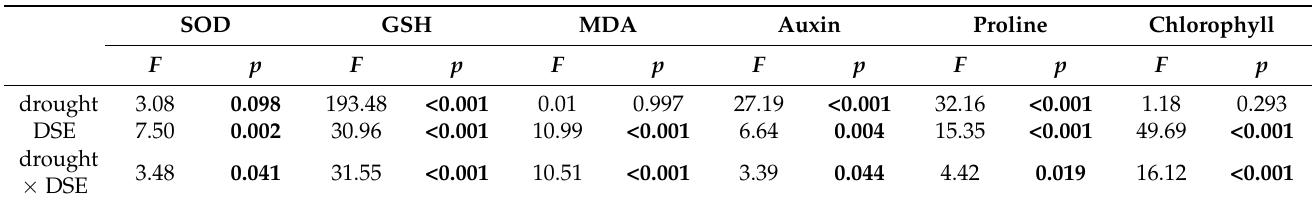
Table 2. Analysis of variance for the effects of drought stress and dark septate endophyte (DSE) inoculation on the physiological traits of Artemisia ordosica